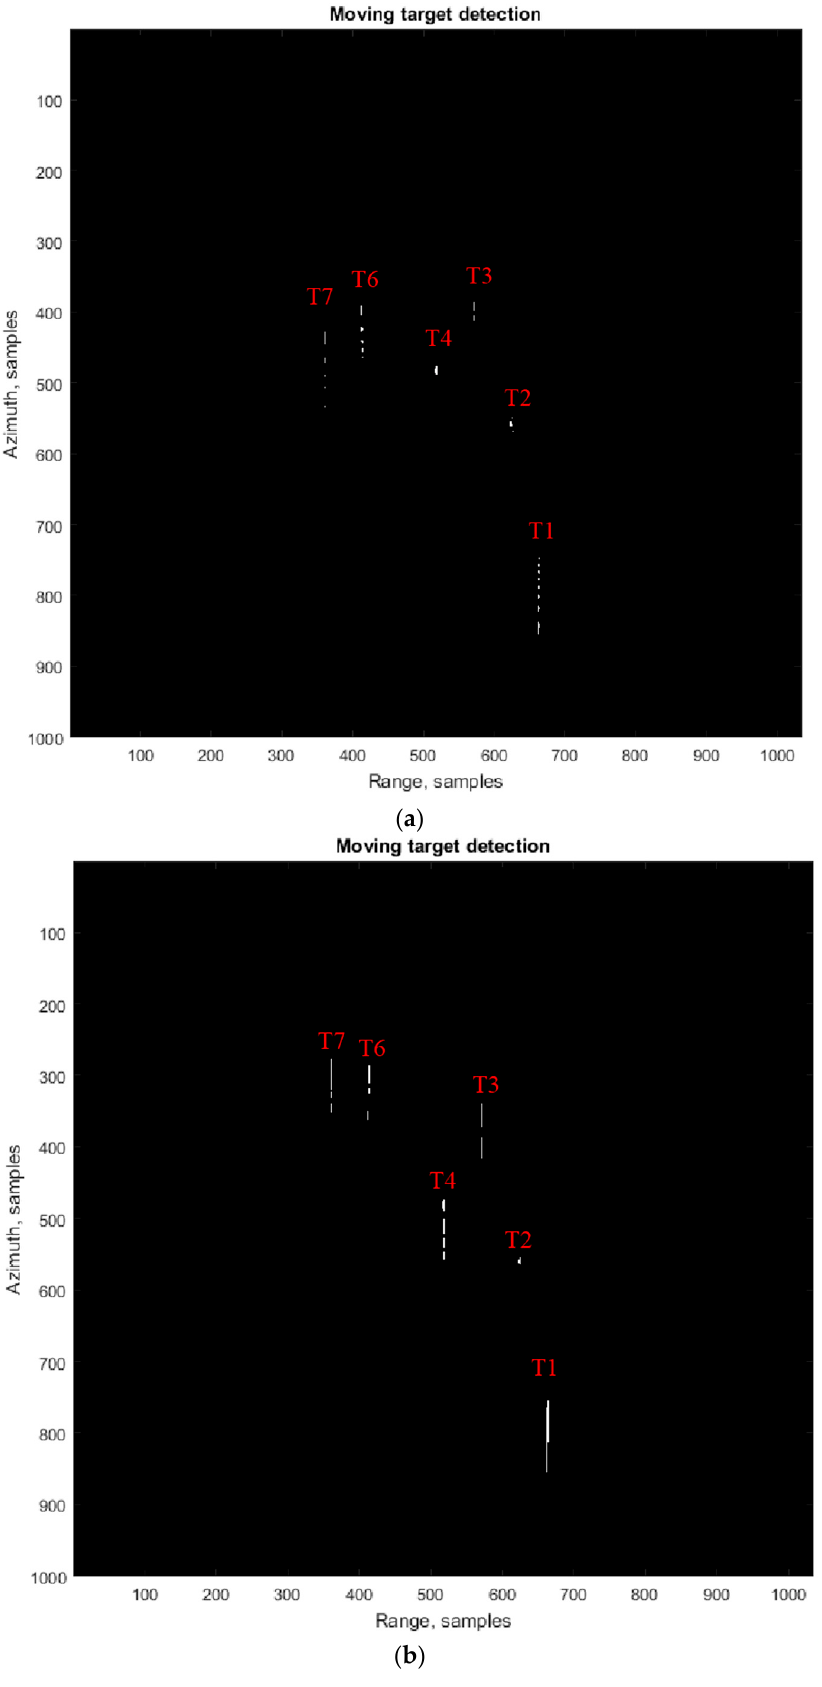
Figure 14. Results of moving target detection algorithm in SAR images of ( a ) moving targets with a background and ( b ) moving targets without a background.